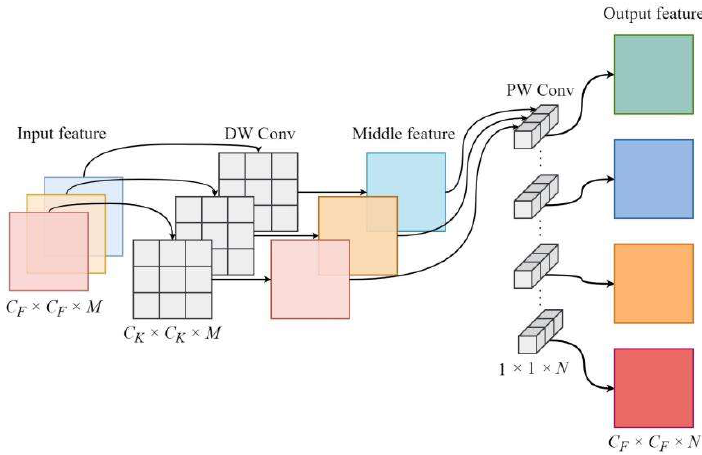
Figure 7. Depthwise separable convolution .